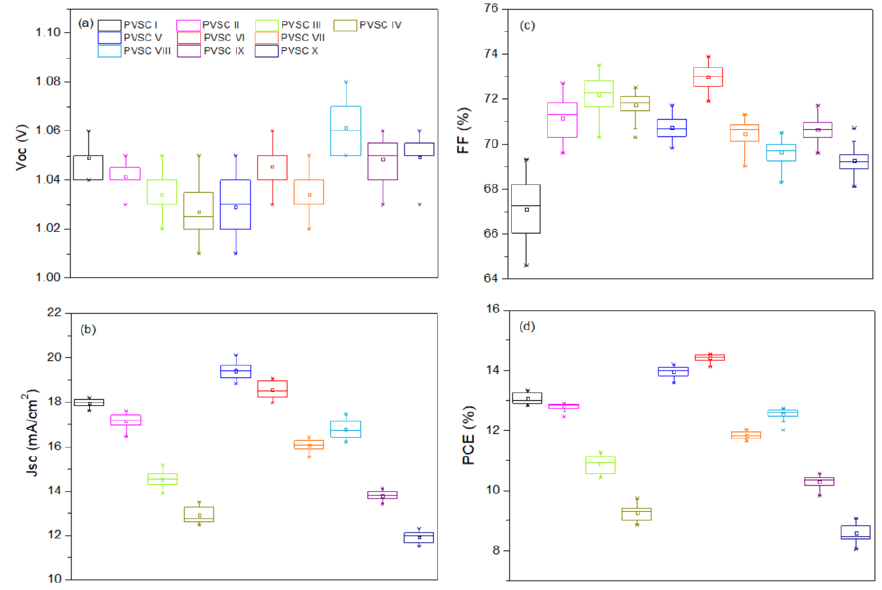
Figure 12. Statistical box plots for the PV parameters ( a ) V OC , ( b ) J SC , ( c ) FF, and ( d ) PCE of 20 un- encapsulated pristine and cellulose derivative (PQF, PQCl, PQBr)–modified MAPbI 3 -based PVSCs.